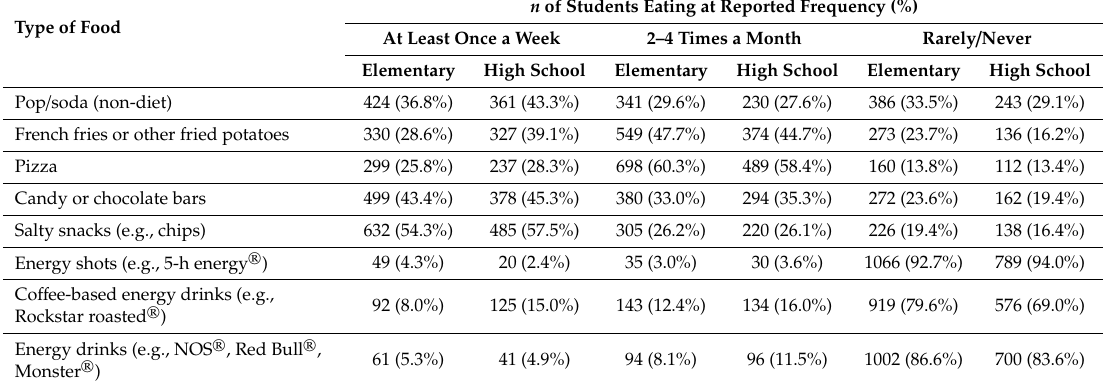
Table 3. Habitual consumption of “other” foods by elementary and secondary students based on the